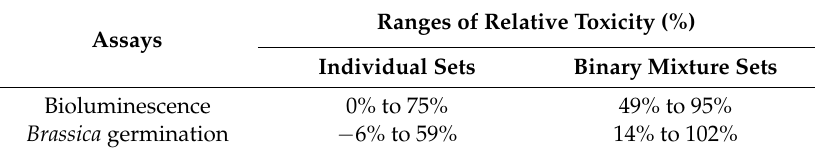
Table 2. Relative toxicity ranges of individual nanoparticles (NPs) and binary mixtures of NPs, as assessed by (a) bioluminescence activity and (b) seed germination